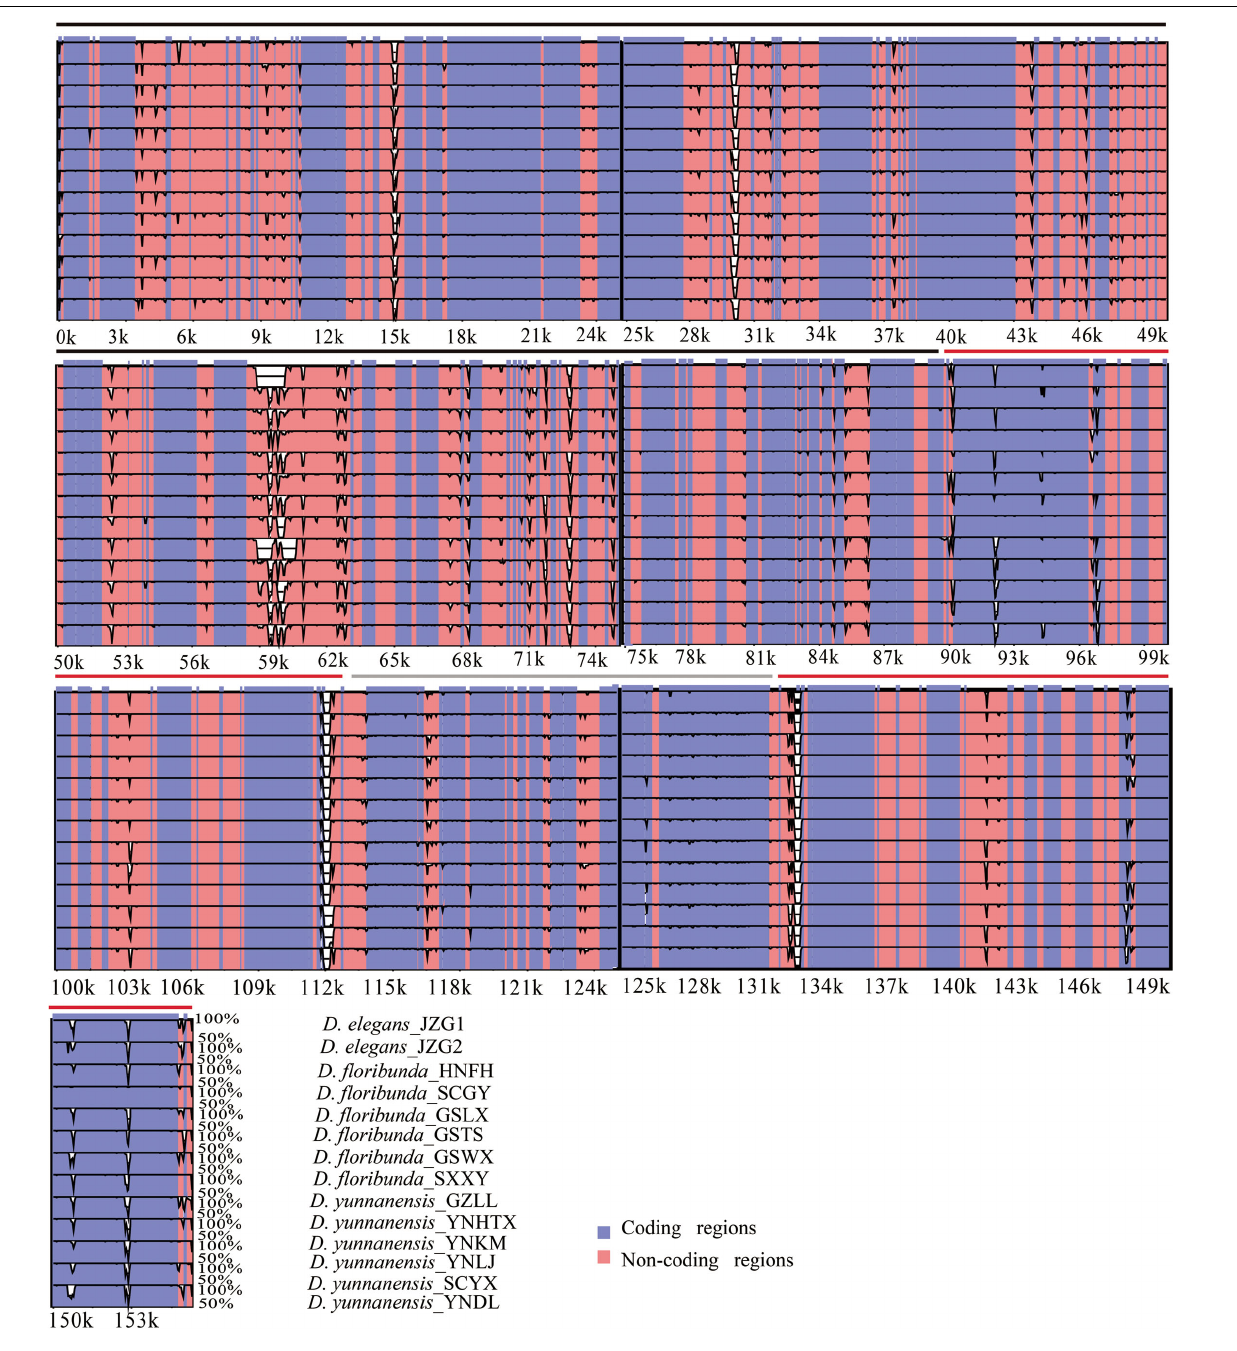
FIGURE 4 | Sequence identity plot of the 14 plastomes in Dipelta , with Dipelta elegans _JZG1 as a reference. The y-axis indicates% identity ranging from 50 to 100% to the reference. Protein-coding genes and intergenic regions are marked in purple and pink, respectively. The black, gray, and red lines show the LSC, SSC, and IR regions,